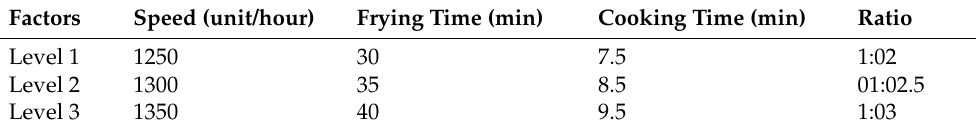
Figure 3. The methodology plan. Table 1. Levels for the controllable factors.